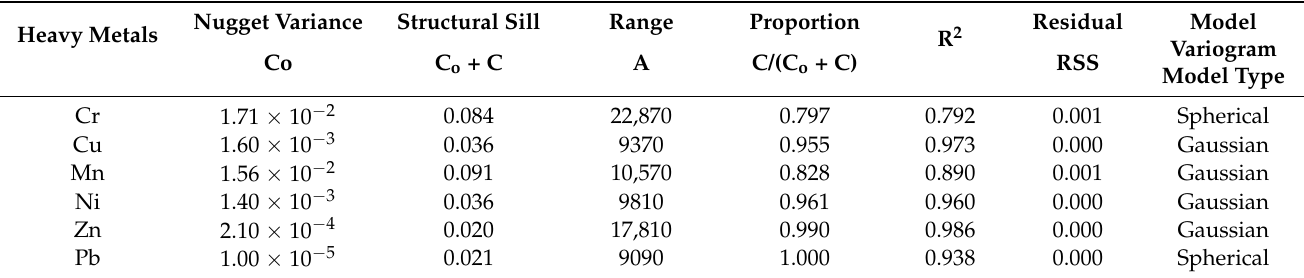
Table 2. The types of soil heavy metals.